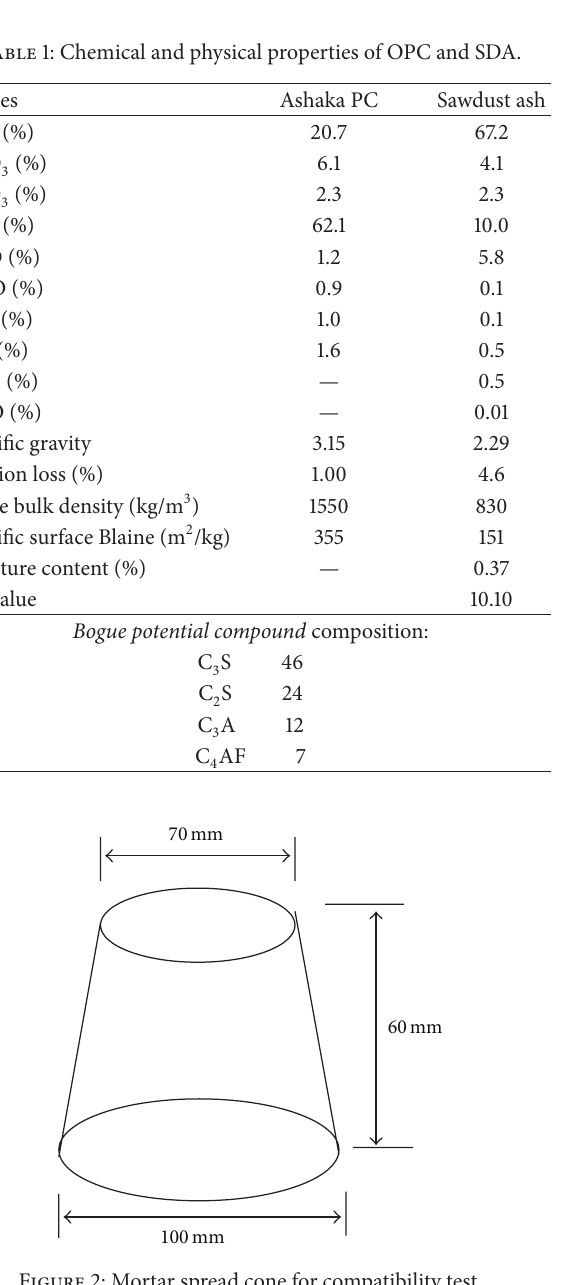
Figure 2: Mortar spread cone for compatibility